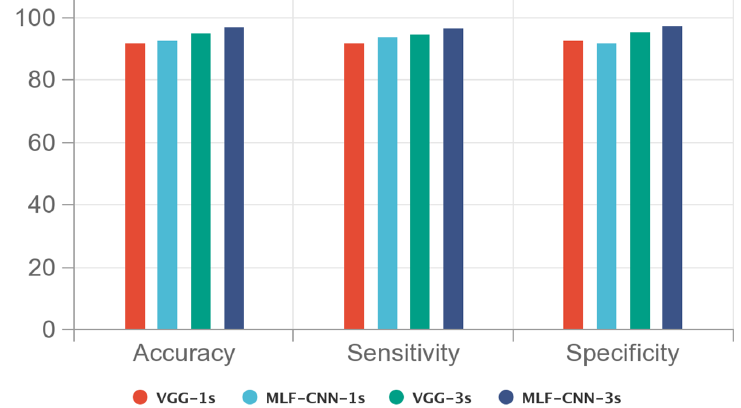
Figure 6. The comparison of results under different segments and models using CHB-MIT dataset and SWT time–frequency